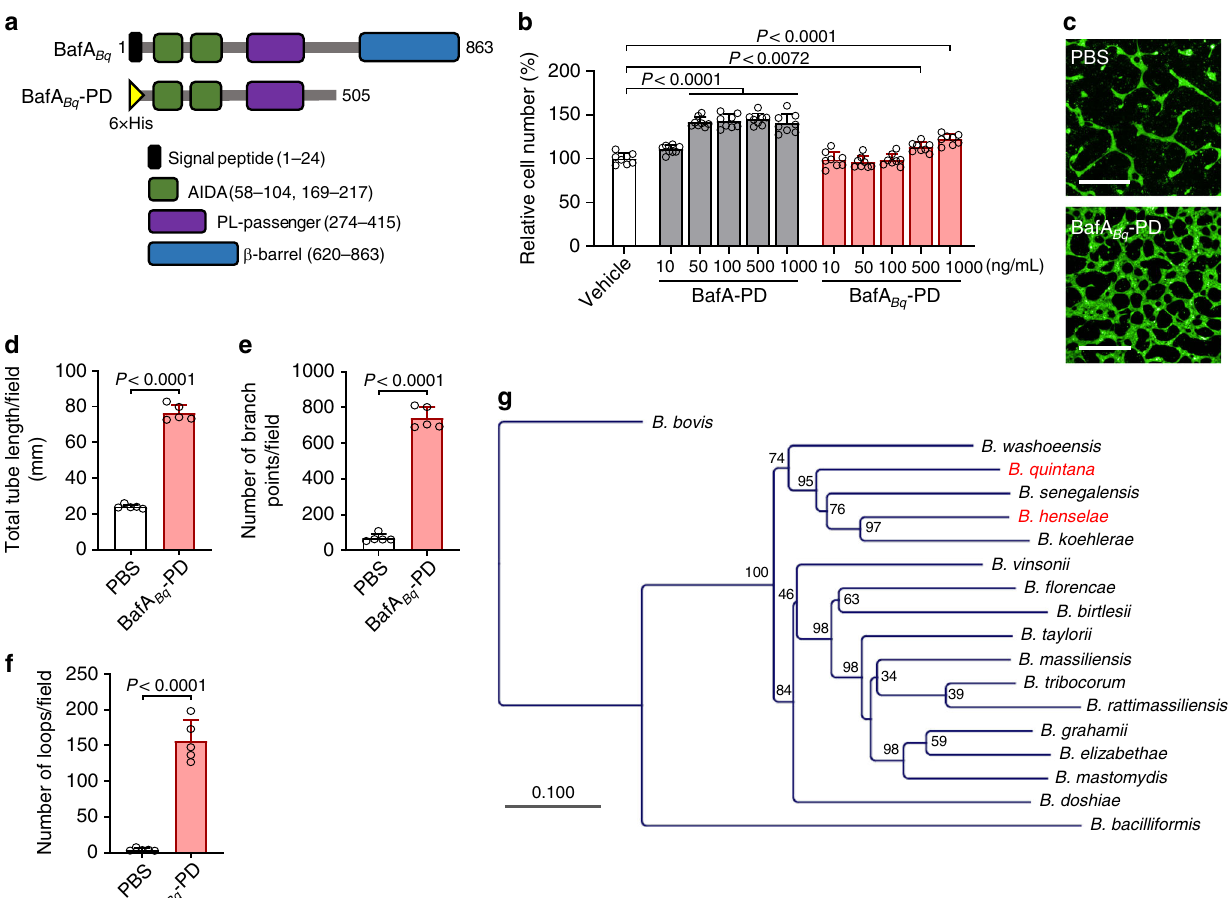
Fig. 5 The BafA homolog from B. quintana possesses in vitro angiogenic activity. a Schematic representation of B. quintana -derived full-length BafA (BafA Bq ) and the recombinant passenger domain (BafA Bq -PD). The full-length BafA Bq has a similar domain structure with the Bh -derived BafA. BafA Bq -PD was constructed as a His-tagged protein from the amino acid residues 25 – 505 of BafA Bq -PD. b Comparison of cell proliferation activities of BafA Bq -PD and BafA-PD ( n = 8 biological replicates). c – f Tube formation assay. HUVECs sandwiched between collagen gels were incubated in the presence of PBS or BafA Bq -PD (300 ng/mL) for 24 h. The tube formation was imaged ( c ), and the total tube length ( d ), number of branch points ( e ), and number of loops ( f ) were calculated as described above. Scale bar = 500 µ m ( n = 6 biological replicates). Bars are colored based on the treatment: white for vehicle or PBS, gray for BafA-PD, and red for BafA Bq -PD ( b – e ). Data are mean ± s.d. ( b , d – f ). Statistical signi fi cance was tested using one-way ANOVA with Dunnett ’ s multiple comparisons test ( b ) or two-tailed unpaired student ’ s t test ( d – f ). g Phylogenetic tree of the BafA family proteins. The red letters indicate the species used in this study. Numbers at nodes indicate the percentage of bootstrap values. Source data are provided as a Source Data fi